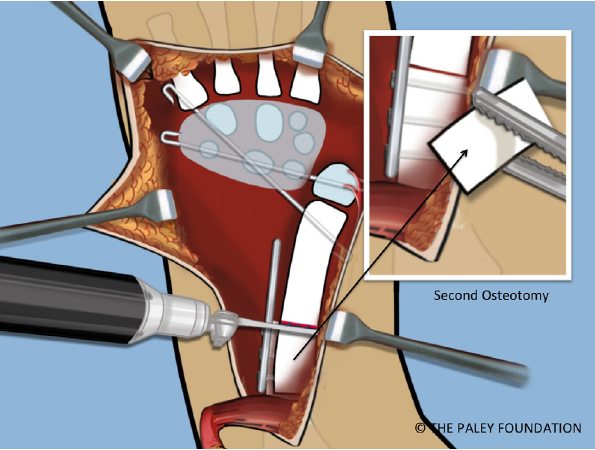
Figure 20. The shortening osteotomy is performed with a